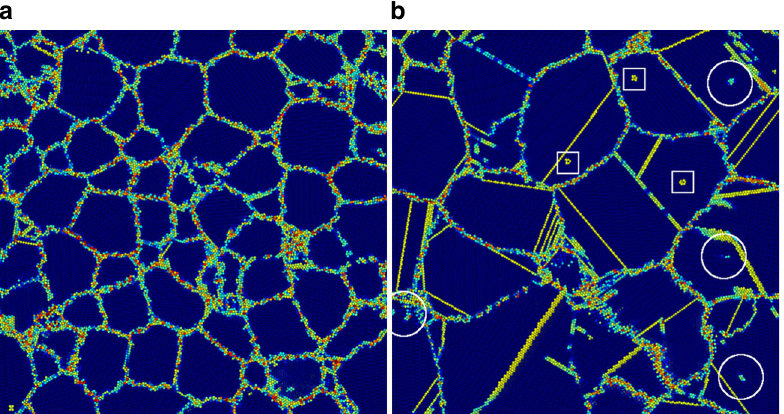
Fig. 1 MD polycrystalline grain growth. Cross-section of a three-dimensional MD grain growth simulation cell. a Initial relaxation (see Methods). b The same cross-section following a 2.5 ns anneal at 0.85 T m . Atom colors are assigned based on centrosymmetry. The white circles indicate dislocations, white squares identify vacancies, and thin yellow lines show twins formed during grain growth. For a full animation of this simulation, see Supplementary Video